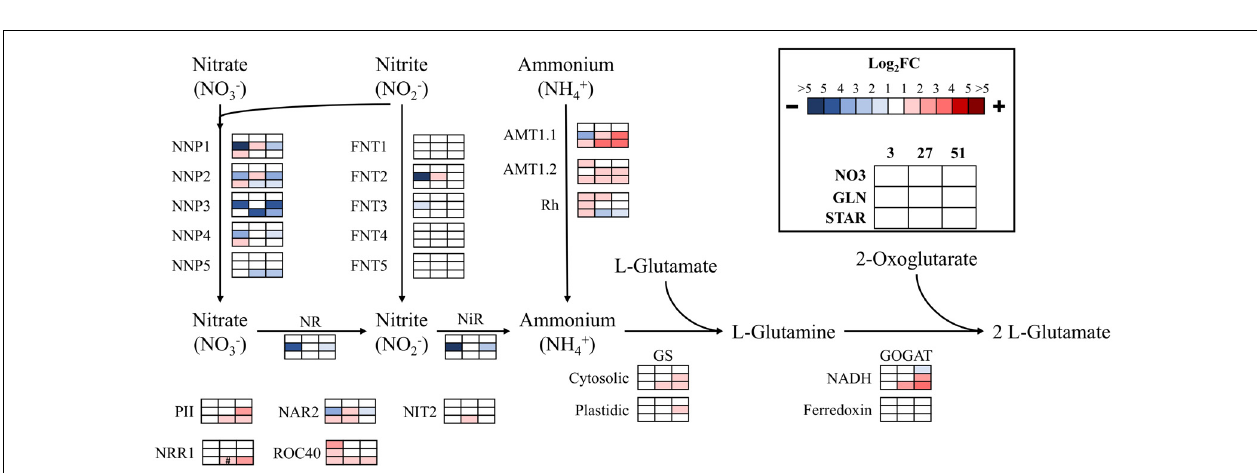
FIGURE 3 | Expression of nitrogen assimilation genes over time. The log 2 fold change values are presented as each value over the inoculum culture value. Comparisons are shown in each condition (NO3, GLN, and STAR) for the entire time course (3, 27, and 51 h). Blue represents downregulation in comparison to the inoculum and red is upregulation in comparison to the inoculum. Colored boxes with # symbols are not statistically significant. Expression data and transcript identities are in Supplementary Data Sheet 1 . Gene abbreviations are NNP, nitrate/nitrite porter; NR, nitrate reductase; FNT, Formate/Nitrite Transporter Family; NiR, nitrite reductase; AMT, ammonium transporter; Rh, Rhesus protein; GS, glutamine synthetase; GOGAT, glutamine oxoglutarate aminotransferase; PII, Nitrogen regulatory protein PII; NAR2, nitrate assimilation related 2; NIT2, transcription factor NIT2; NRR1, nitrogen response regulator 1; ROC40, MYB-related transcription